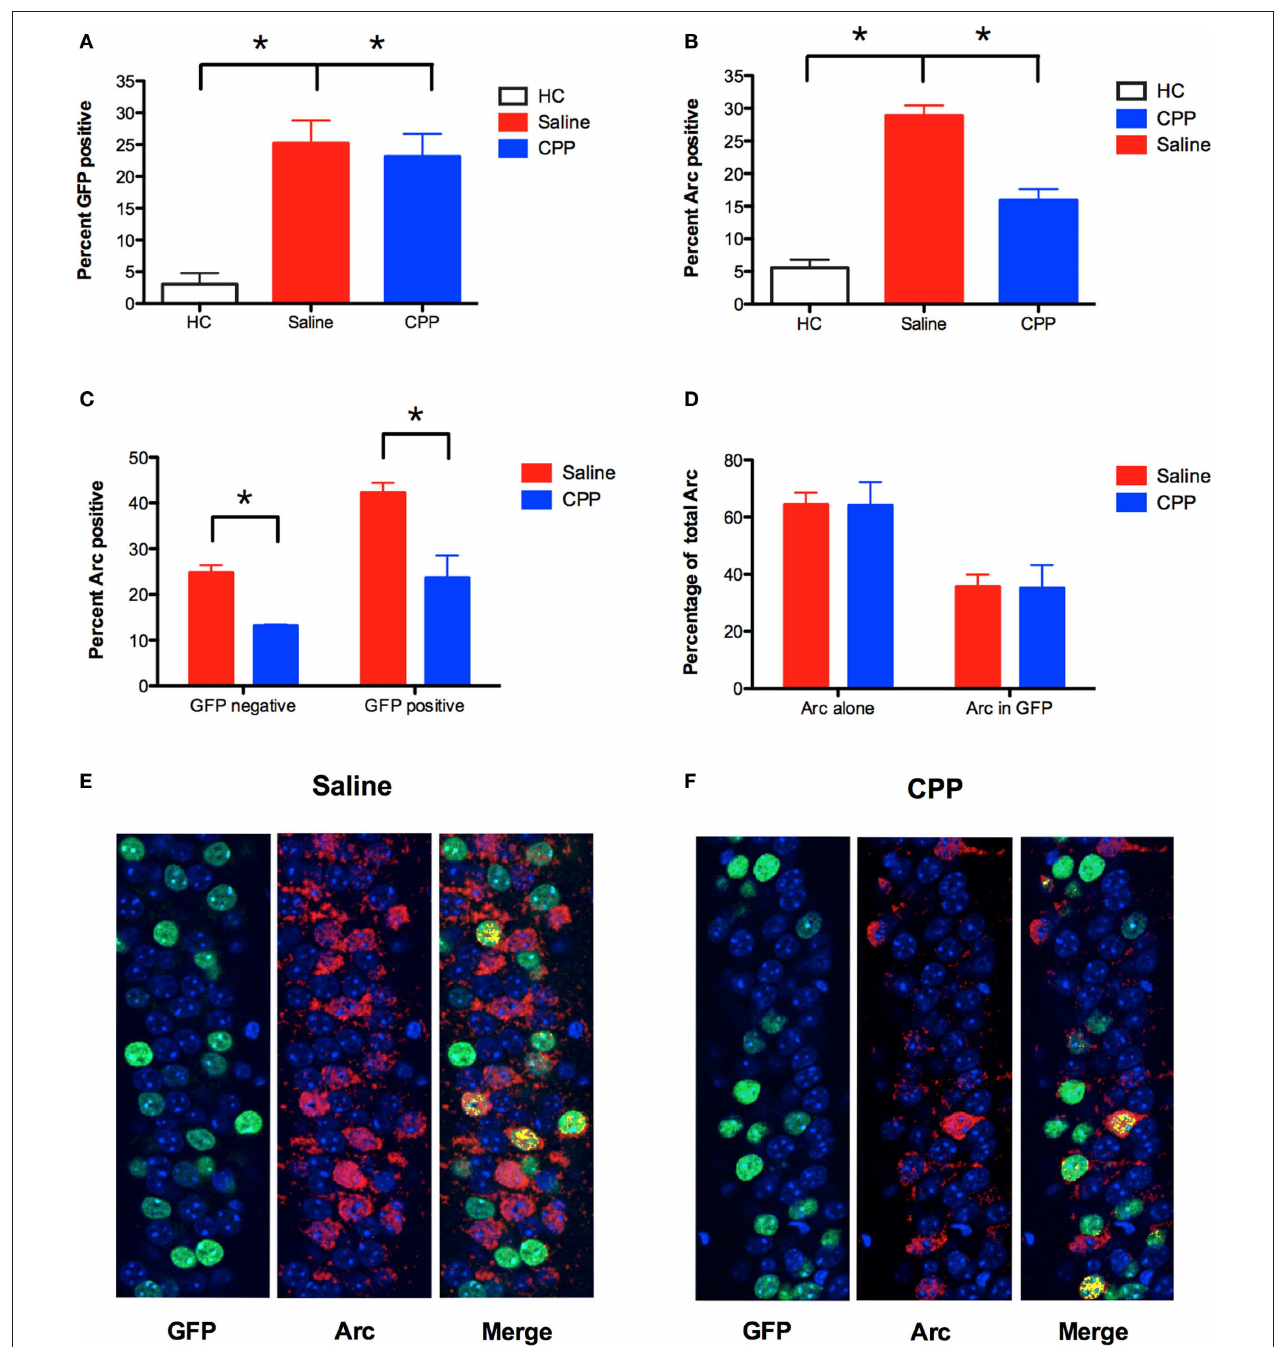
Figure 6 | NMDAr activation is required for Arc expression in previously activated neurons. (A) Using the protocol described in Figure 5A , TetTag mice were conditioned off of Dox in context A, and conditioned in context B in the presence of saline ( n = 5) or CPP ( n = 3) 5 days later. Expression of GFP protein was increased in both saline and CPP groups relative to homecage controls (HC; n = 3). Results are shown as percentage of CA1 cell nuclei expressing GFP labeling. (B) Arc expression in context B was significantly reduced by an injection of CPP prior to training. Results are shown as percentage of CA1 cell nuclei expressing Arc labeling. (C) CPP reduced the expression of Arc in both